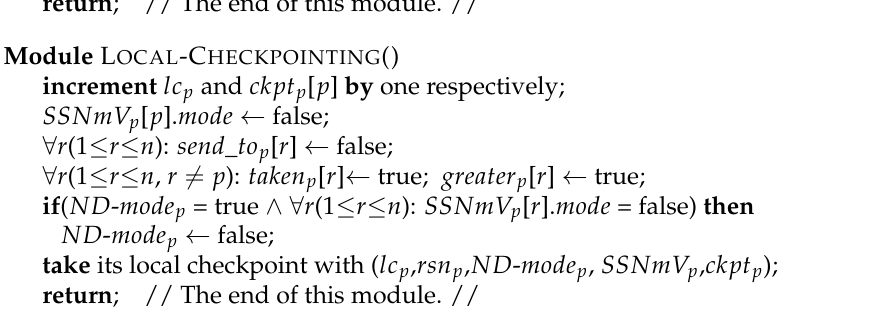
Figure 4. Modules of p for